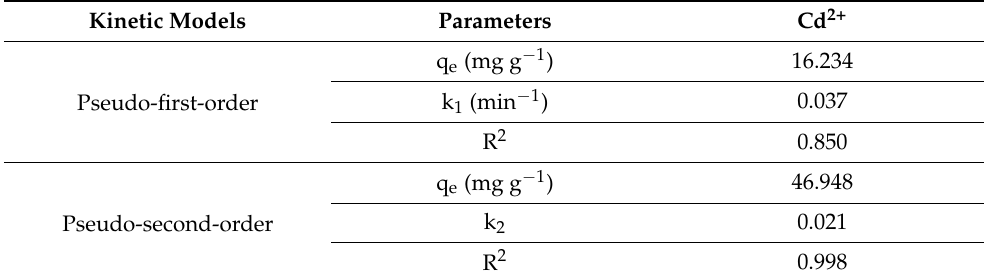
Figure 8. Removal of cadmium at different concentrations (10 mg L − 1 , 20 mg L − 1 , and 30 mg L − 1 ) with the change in contact time (20–120 min at 20 mg adsorbent dosage). The pseudo ‐ first ‐ order rate constant k 1, pseudo ‐ second ‐ order rate constant k 2 , and the linear correlation coefficient R 2 are shown in Table 6. Table 6. Constants of kinetic models for Cd 2+ adsorption at pH 6, temperature 25 ± 2 °C, and contact time 120 min.